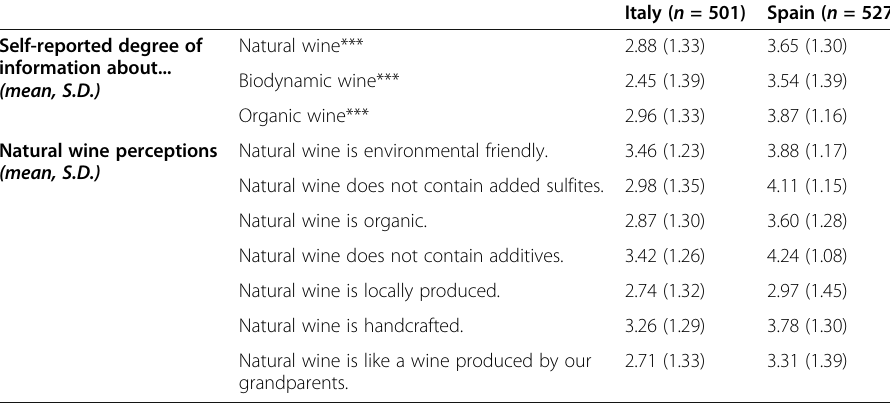
Italy ( n = 501) Spain ( n = 527)